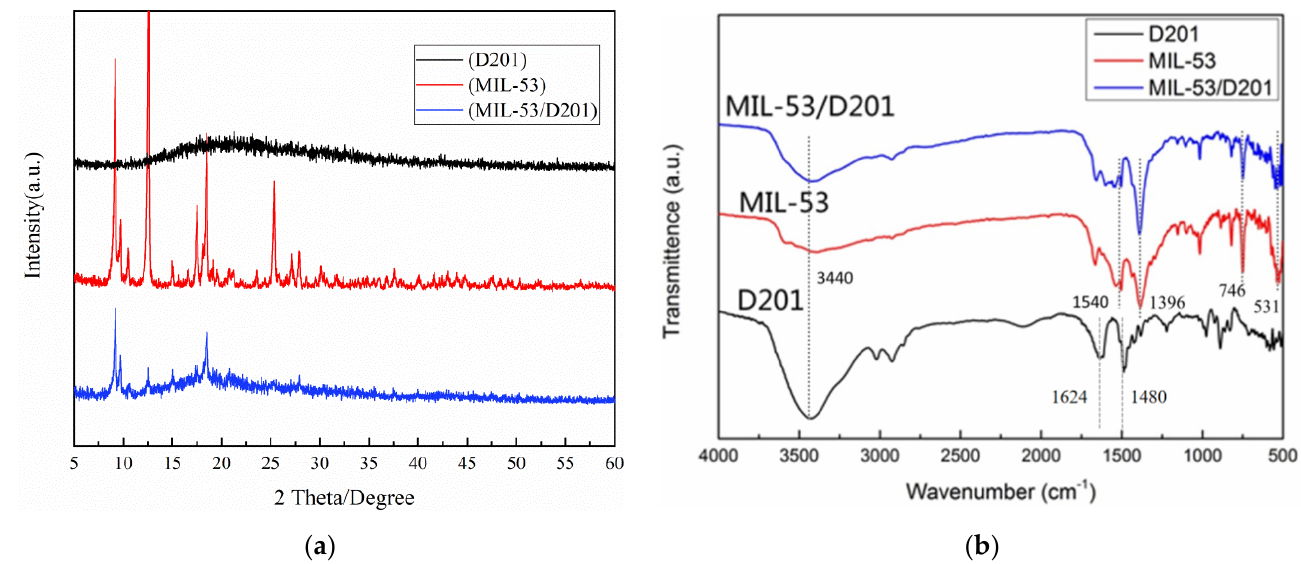
Figure 3. XRD ( a ) and FT − IR ( b ) of MIL-53/D201 composite and their